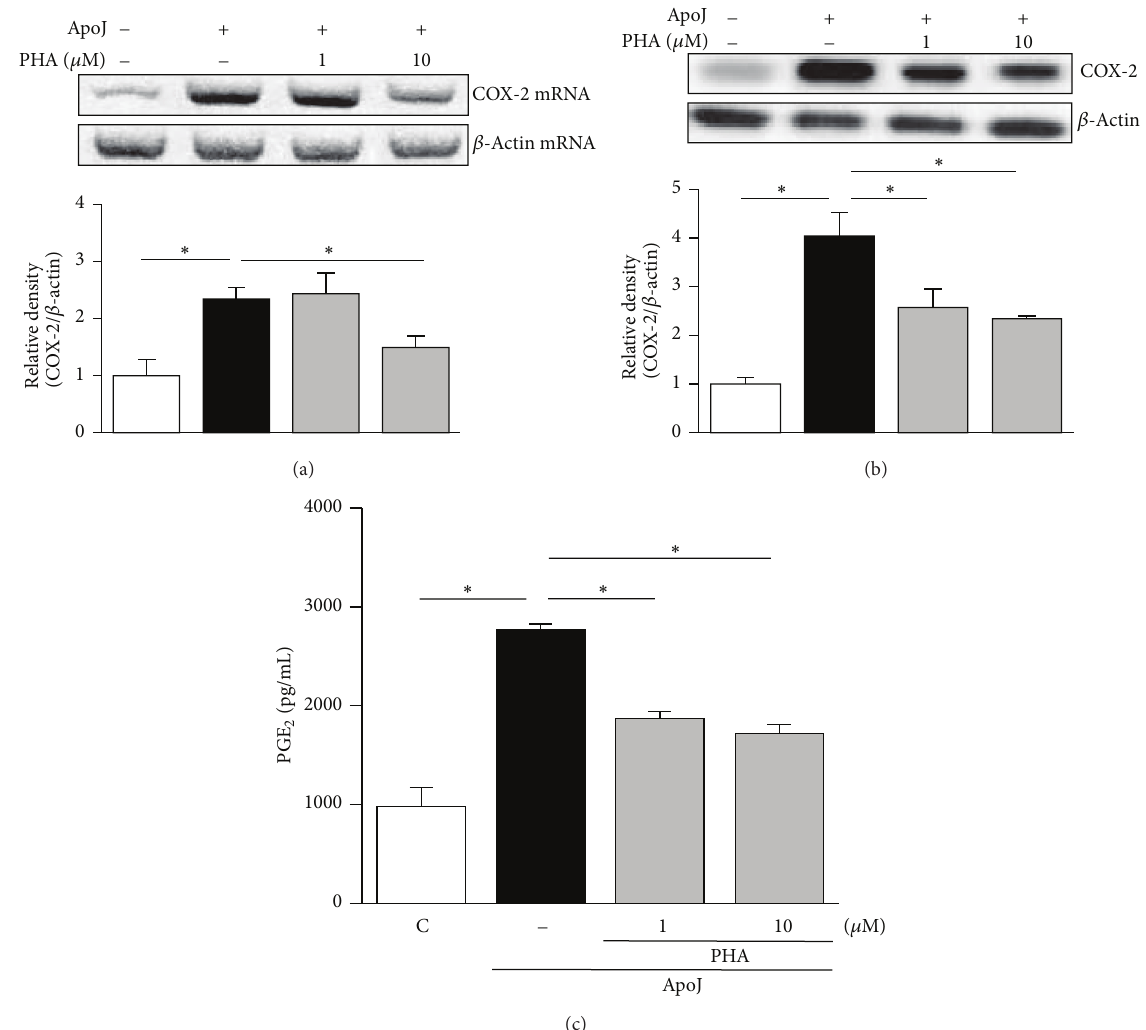
Figure 7: HGF receptor antagonist suppresses COX-2 expression and PGE 2 production in peritoneal macrophages in response to apoptotic cells. Murine peritoneal macrophages were pretreated with PHA-665752 (1 or 10 𝜇 M) for 1h and then stimulated with apoptotic Jurkat cells (ApoJ). (a) At 2 h after in vitro exposure to ApoJ, COX-2 mRNA levels were analyzed by semiquantitative RT-PCR. At 24 h after in vitro exposure to ApoJ, total cell lysates were immunoblotted for COX-2 (b) and cell supernatants were measured for PGE 2 by EIA (c). Values represent mean ± SEM of three or more separate experiments; ∗ 𝑃 < 0.05